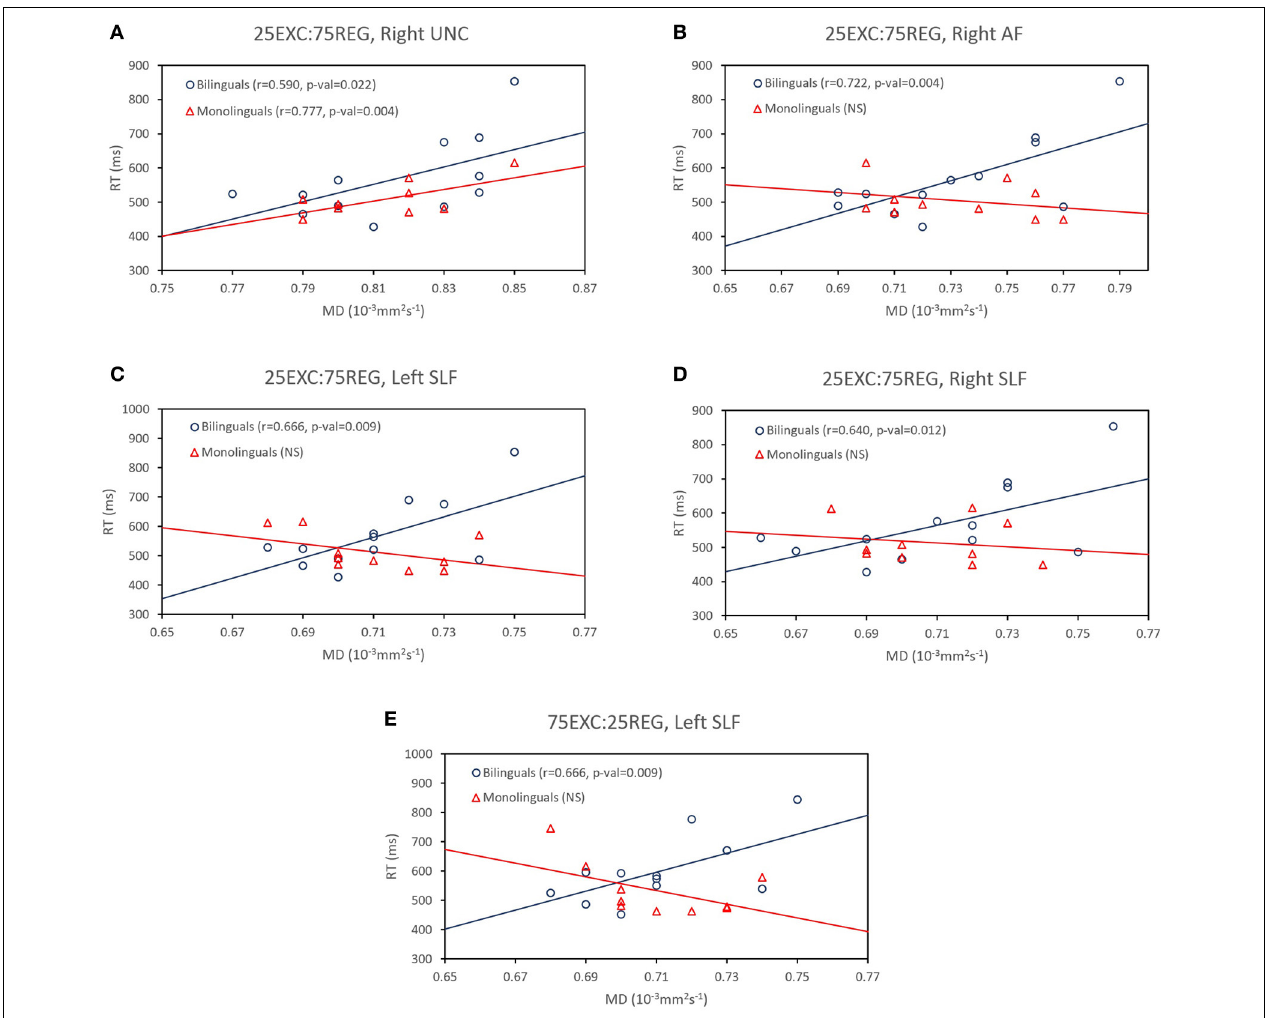
FIGURE 2 | (A) Significant correlations between MD values in the right uncinated fasciculus (UF) and reaction time in the 25EXC:75REG list in both monolingual and bilingual groups. (B–D) Significantly higher correlations in bilinguals than in monolinguals between reaction time in the 25EXC:75REG